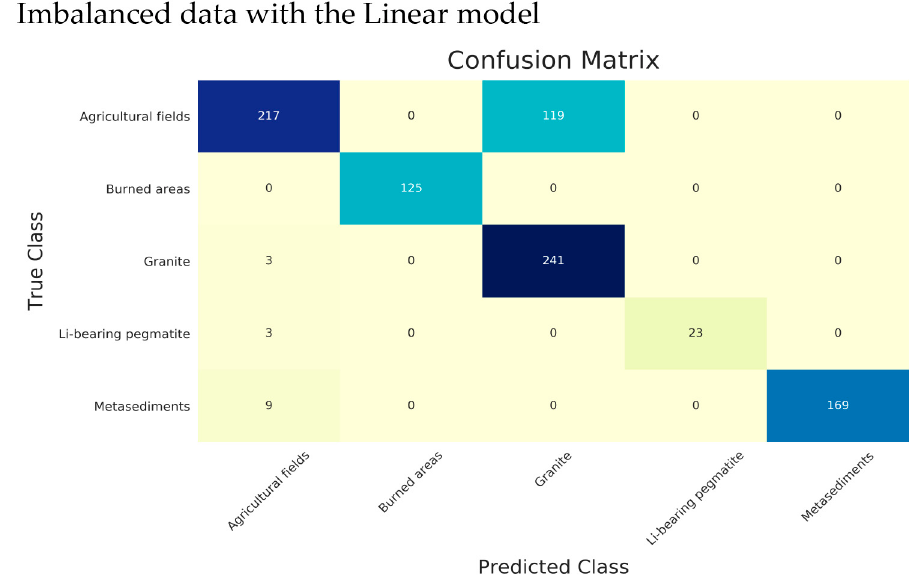
Figure A1. Confusion matrix for the Linear-SVM model built on the imbalanced dataset.